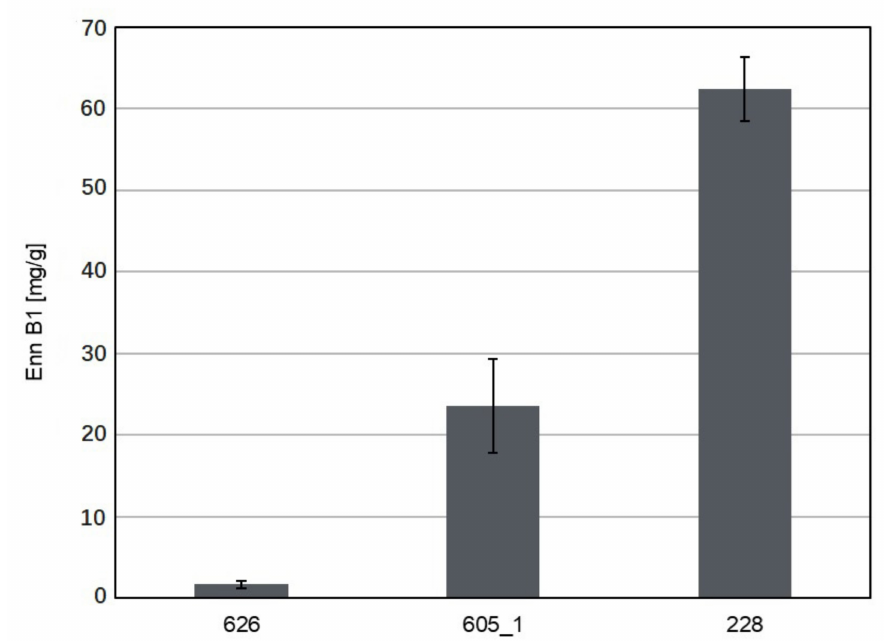
Figure 2. Enniatin B1 production by S. strictum 626, 605_1 and 228